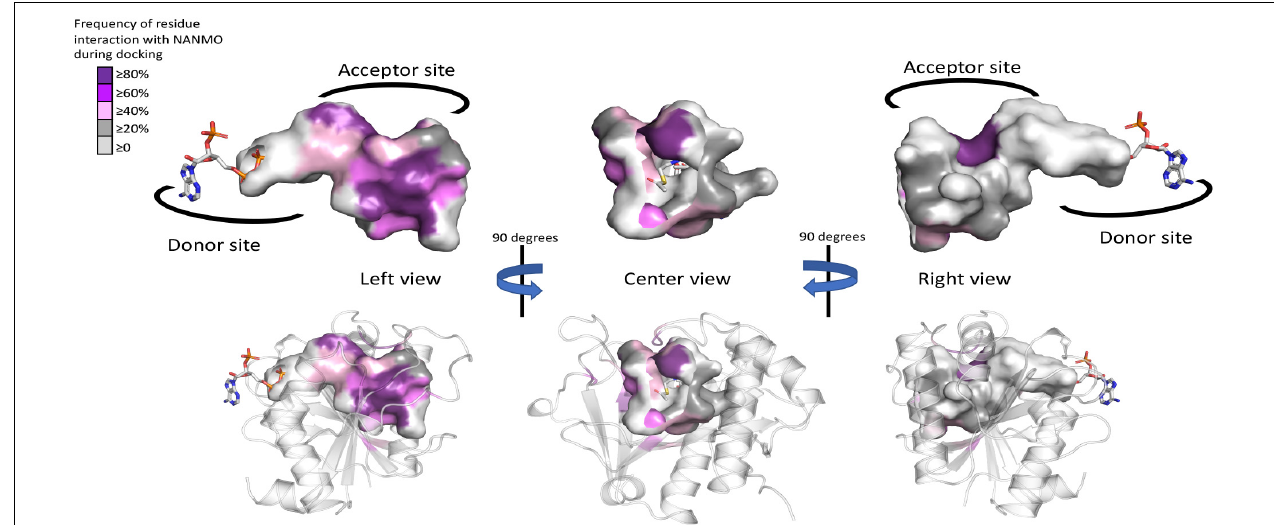
FIGURE 7 | Frequency of WT PA3944 acceptor site interactions with NANMO during docking studies. All ligand interaction maps across all docking experiments with NANMO pointed toward the donor site were compiled and were analyzed to determine residues that most frequently interacted with NANMO. Residues were colored based on frequency (gradient from purple for high frequency to gray for low frequency) on the surface of the acceptor site. AcCoA is shown as sticks. More specific details of separate docking studies can be found in Supplementary Table S1 .